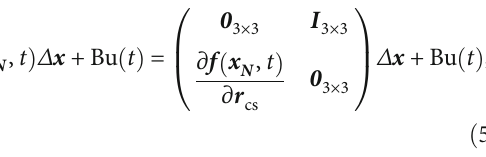
are represented by the black lines, while other nominal orbits are represented by the blue lines.